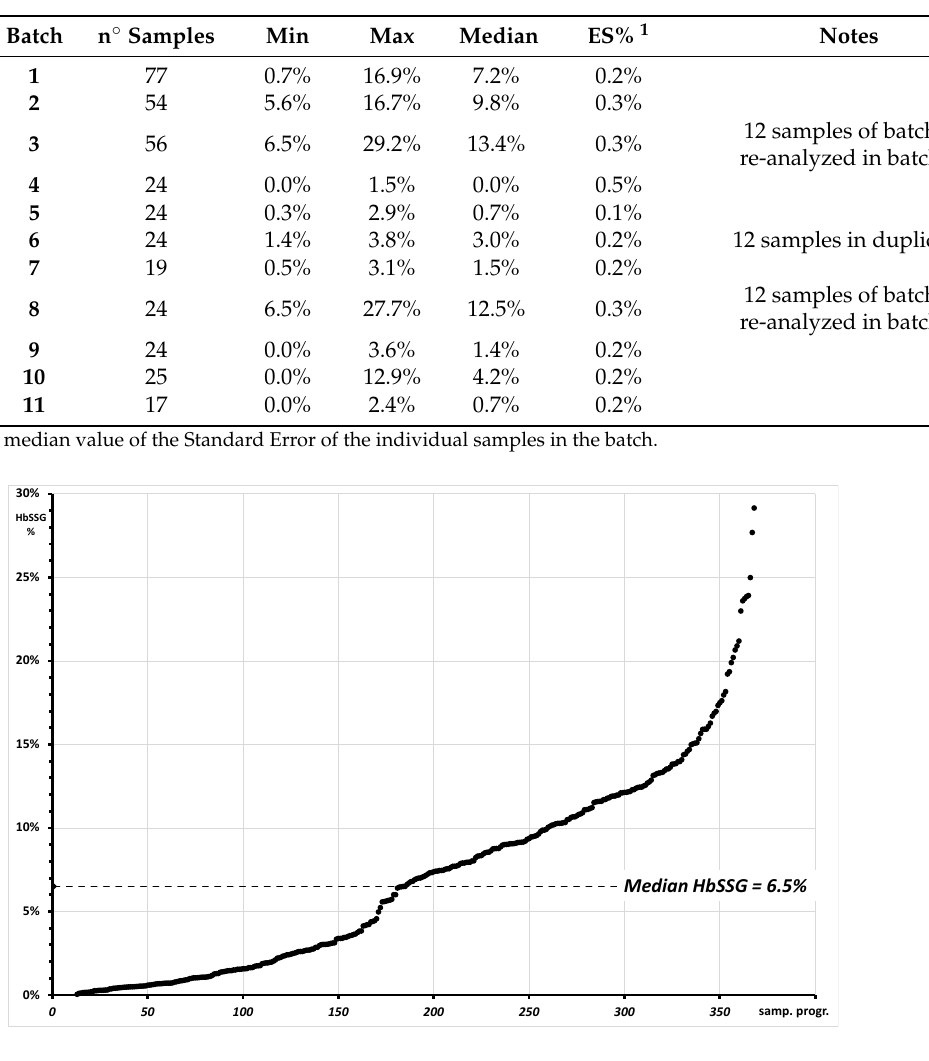
Figure 8. Relationship of the SE% of the 368 measurements of glutationyl hemoglobin (Figure 5) and of the respective value of HbSSG%. The vertical line highlights the median value of the SE in the measured samples. The values of the SE span from ±0.03% to ±1.2%, with a median SE of ±0.2% and me- dian values for the batches between ±0.1% and ±0.5%. The insert of Figure 5 shows a plot of SE vs. HbSSG percent in the samples with a few extreme SE values measured both for very low and for some very high values. While the former corresponds to samples where